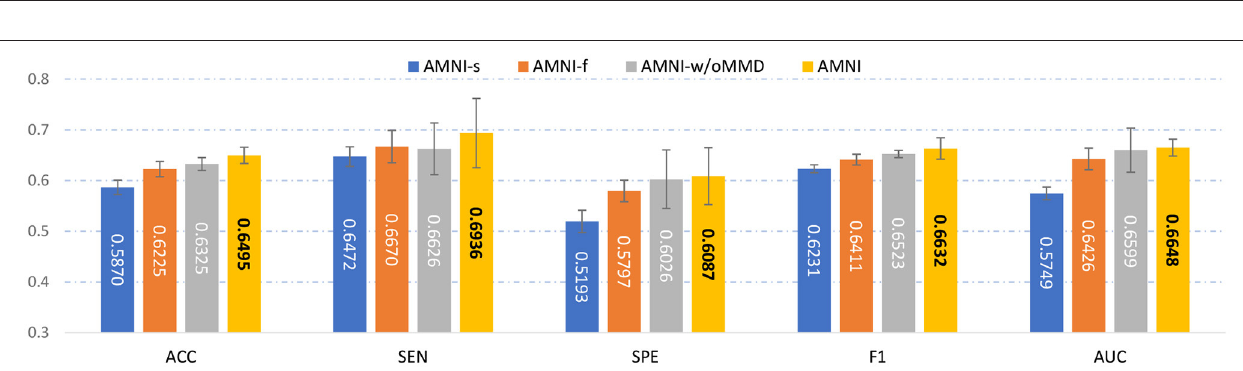
FIGURE 3 | Visualization of feature distributions from the PP+SVM and the proposed AMNI models via t-SNE (Van der Maaten and Hinton, 2008). The horizontal and vertical axes denote two dimensions after feature mapping. (A) Distribution of features derived from PP+SVM. (B) Distribution of features derived from AMNI.